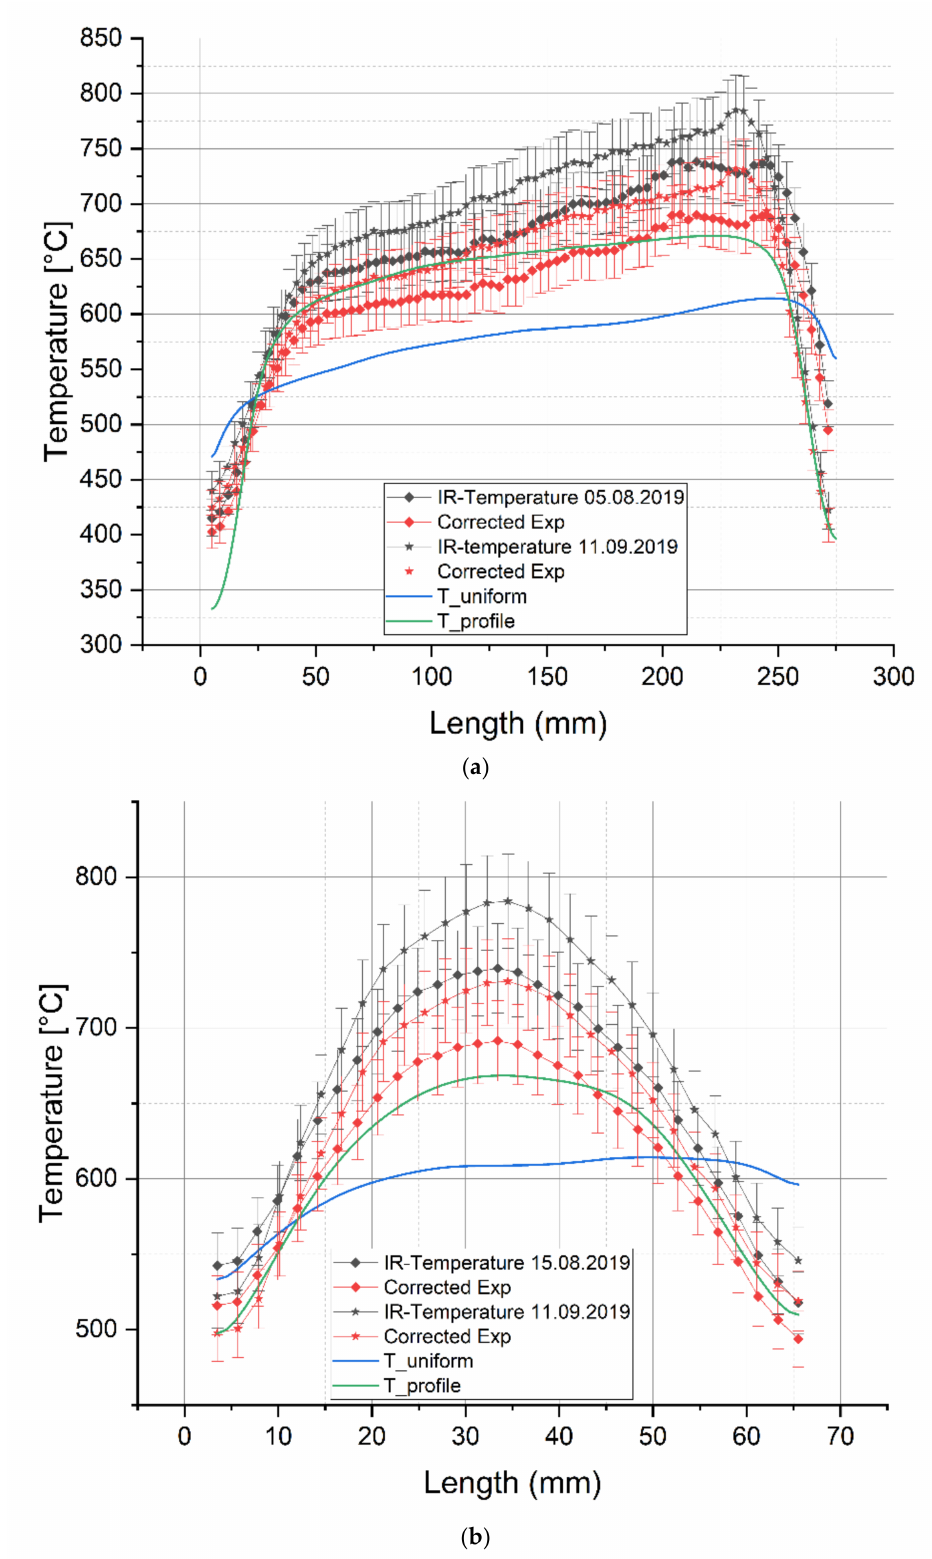
Figure 12. FG mock-up temperature profiles obtained from IR camera, the corresponding corrected profiles and (CFX) simulated temperature profiles: ( a ) axial temperature profile; ( b ) transversal temperature profile. The profiles are taken through the point of maximum temperature of the temperature